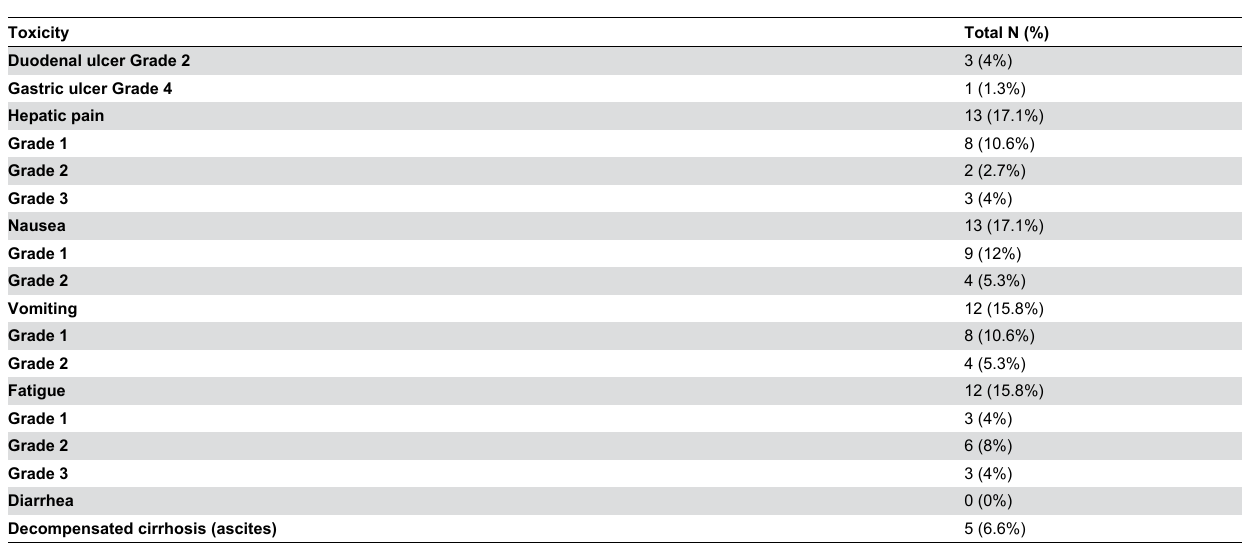
Table 6. Toxicities (n=75